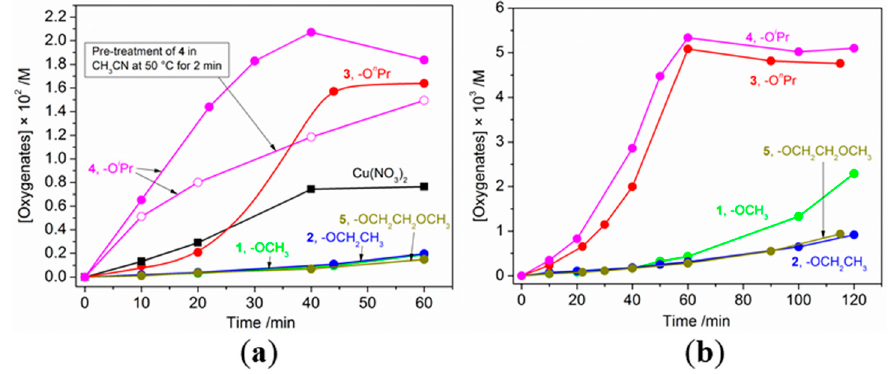
Figure 4. Accumulations of the reaction products (sum of cyclohexanol and cyclohexanone) in the oxidation of cyclohexane (0.2 M) with H 2 O 2 (( a ): 0.5 M, 2.5 equiv.; ( b ): 0.2 M, 1 equiv.) catalysed by 1 – 5 (1 × 10 − 3 M) and by Cu(NO 3 ) 2 (1 × 10 − 3 M) in the presence of pyridine (0.01 M) in acetonitrile at 50 °C.